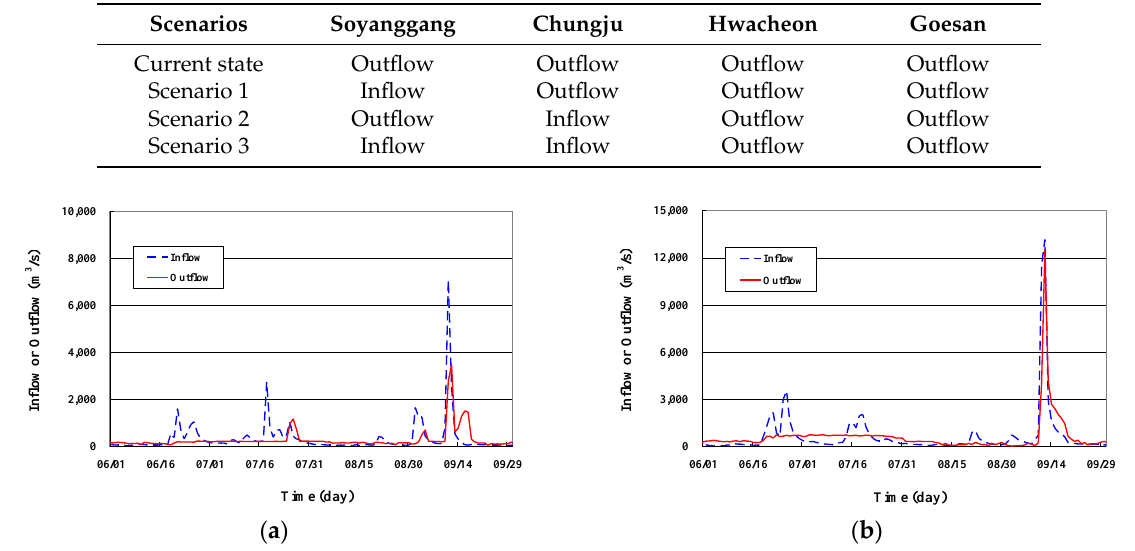
Table 1. Inlet Conditions at the Upper Dams.